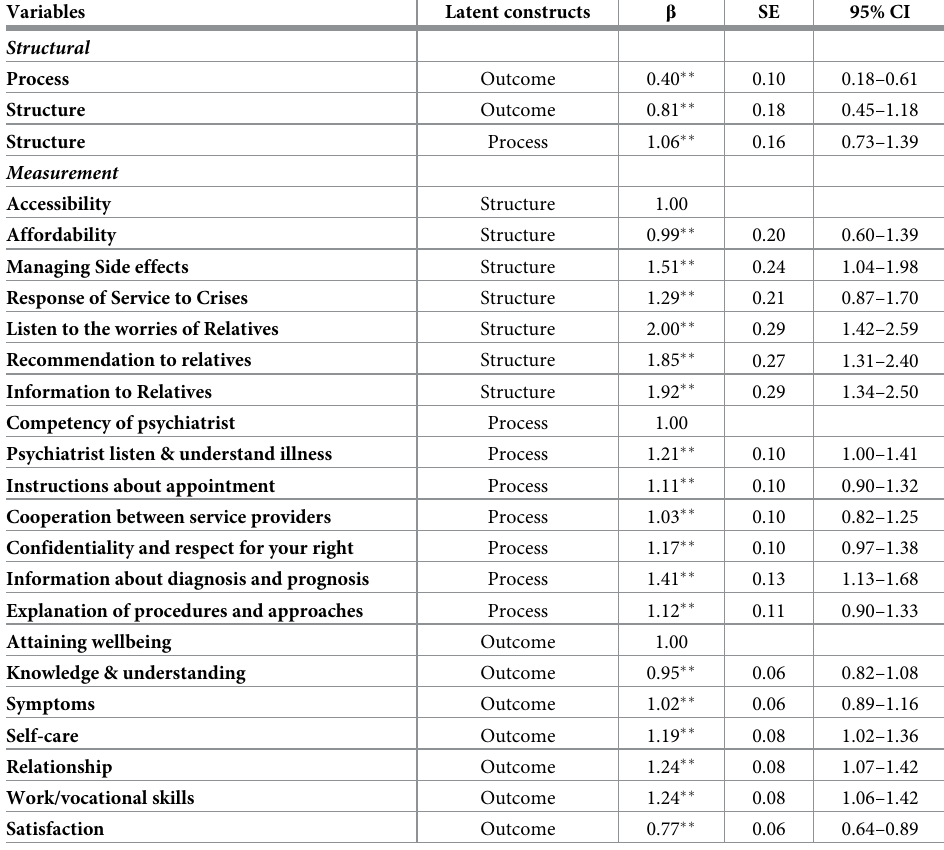
Table 4. Standardized coefficient estimates for CFA.